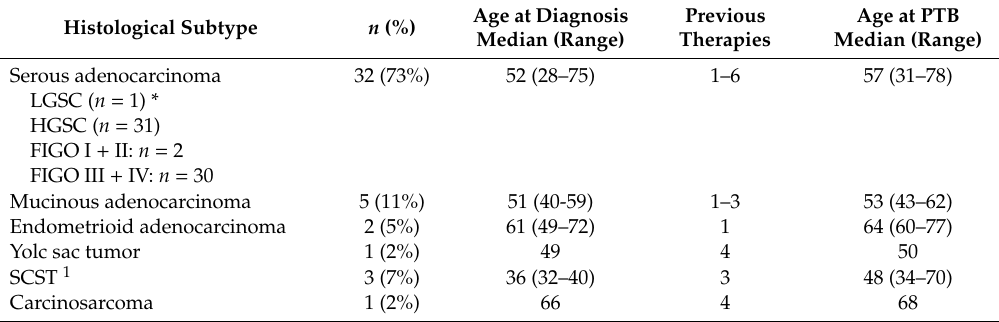
Table 1. Patient characteristics.